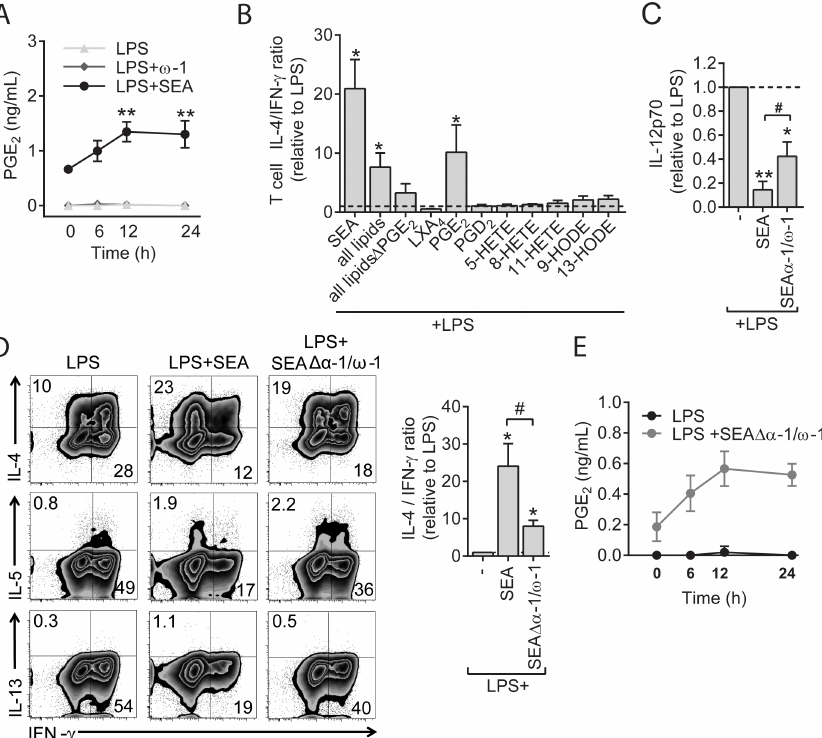
Fig 1. SEA stimulates PGE 2 secretion and primes Th2 responses independently of ω -1 in human moDCs. (A) PGE 2 concentration in supernatants from moDC cultures after stimulation with indicated reagents. Concentrations are determined based on an internal standard. Data represent mean ± SEM of 4 independent experiments. (B) moDCs stimulated with indicated lipids (concentration of 2.5 ng/mL for LXA 4 , PGE 2 , and PGD 2 ; 12.5 μ g/mL for 5-HETE, 8-HETE, and 11-HETE; 25 μ g/mL 9-HODE and 13-HODE) were analyzed for Th2 polarizing potential as described in Materials and methods. The ratio of percentage of IL-4 + over percentage of IFN- γ + T cells based on intracellular cytokine staining was calculated relative to the control condition. (C) moDCs were pulsed with indicated stimuli and subsequently cocultured with a CD40L-expressing cell line. Supernatants were collected after 24 h, and IL-12p70 concentration was determined by ELISA. (D) T-cell polarization was determined as in panel B. Top and bottom panels show representative flow cytometry plots of intracellular staining of CD4 + T cells for indicated cytokines, and the ratio of IL-4 over IFN- γ ratio of these plots based on 4 experiments. Numbers in plots represent frequencies of cells in indicated quadrants. (E) PGE 2 levels as determined by LC-MS/MS in supernatants of moDCs stimulated with indicated stimuli. Data represent mean ± SEM of 3 independent experiments. (A) Statistical significance of different time points per condition compared to baseline (0 h) time point. “ (cid:3) ” and “#”: P < 0.05; “ (cid:3)(cid:3) ”: P < 0.01. (A) based on two-way ANOVA test or (B–D) for significantly different with the LPS control ( (cid:3) ) or between-test conditions (#) based on paired analysis (paired Student t test). Underlying data can be found in S1 Data. CD4, cluster of differentiation 4; HETE, Hydroxyeicosatetraenoic acid; HODE, Hydroxyoctadecadienoic acid; IFN- γ , interferon γ ; IL-4, interleukin 4; LC-MS/MS, liquid chromatography tandem mass spectrometry; LPS, lipopolysaccharide; LXA 4 , lipoxin A 4 ; moDC, monocyte-derived DC; PGE 2 , prostaglandin E2; SEA, soluble egg antigen; Th2, T helper